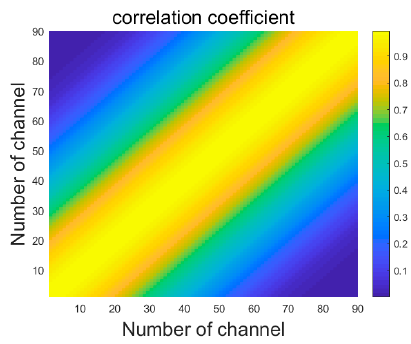
Figure 3. Two samples hyperspectral cross-correlation coefficient distribution of 91 channels.